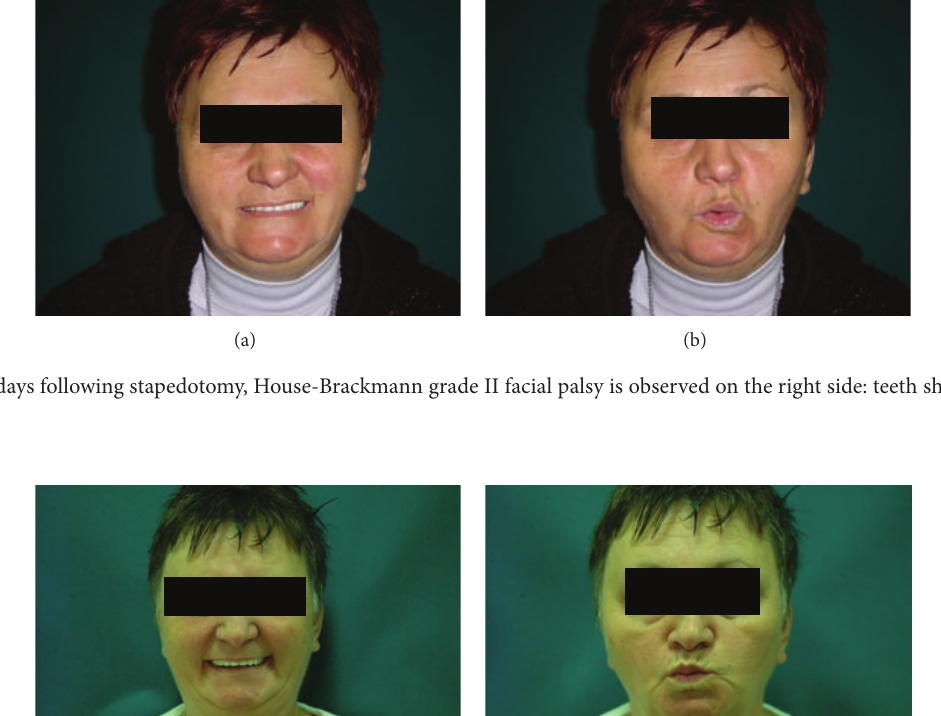
sides, while the multiple-frequency tympanogram indicated a resonance frequency of 1000 Hz on the left and of 1100 Hz resonance on the right